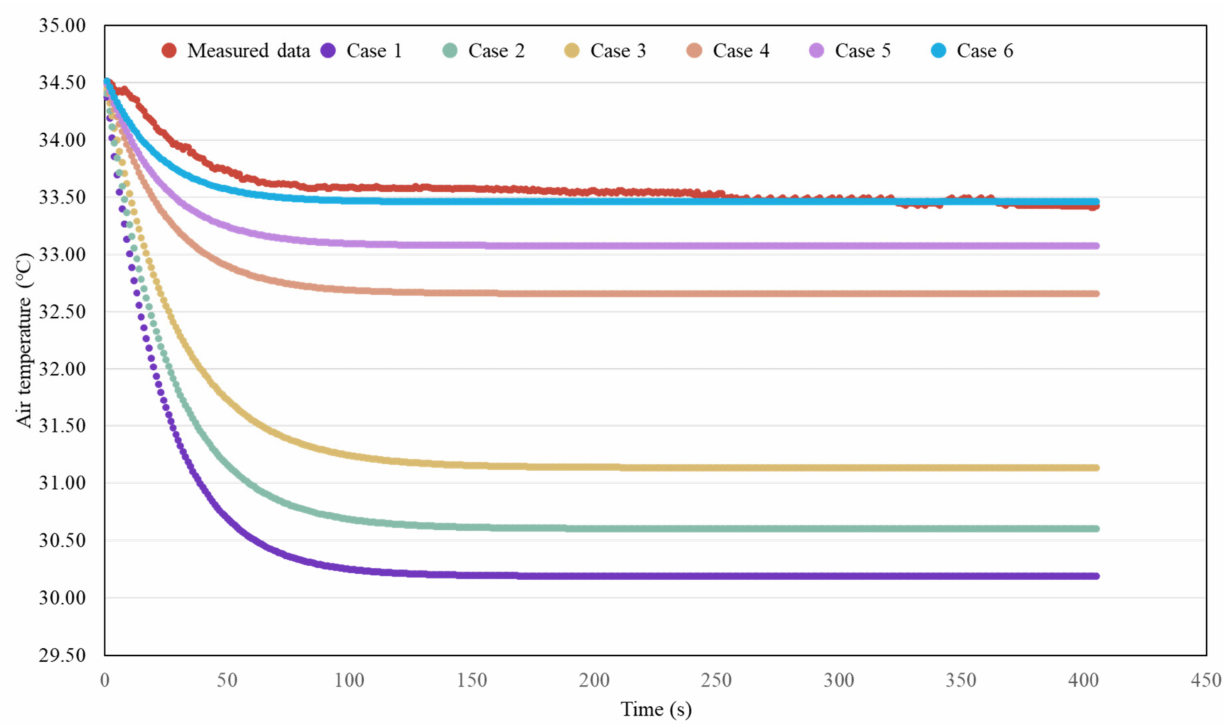
Figure 7. Thermal environment of the measured data and calculation data of the numerical model according to the ventilation rate and infiltration